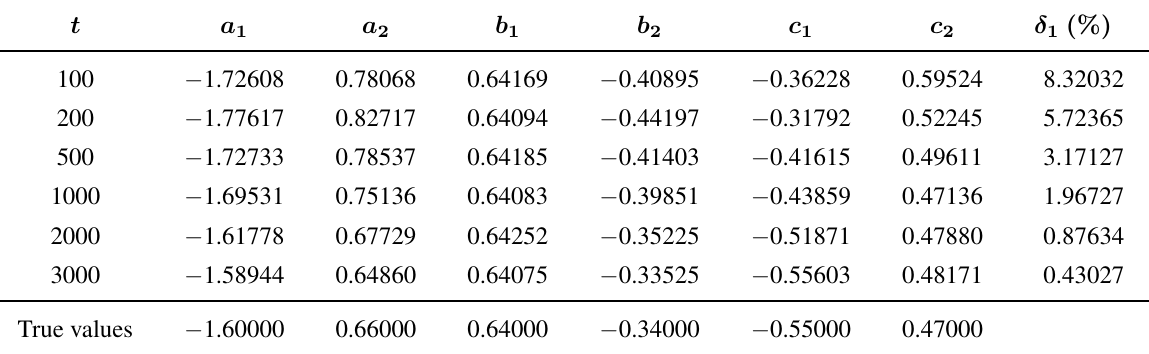
Table 2. The model equivalence-based recursive least squares (ME-RLS) estimates and errors.